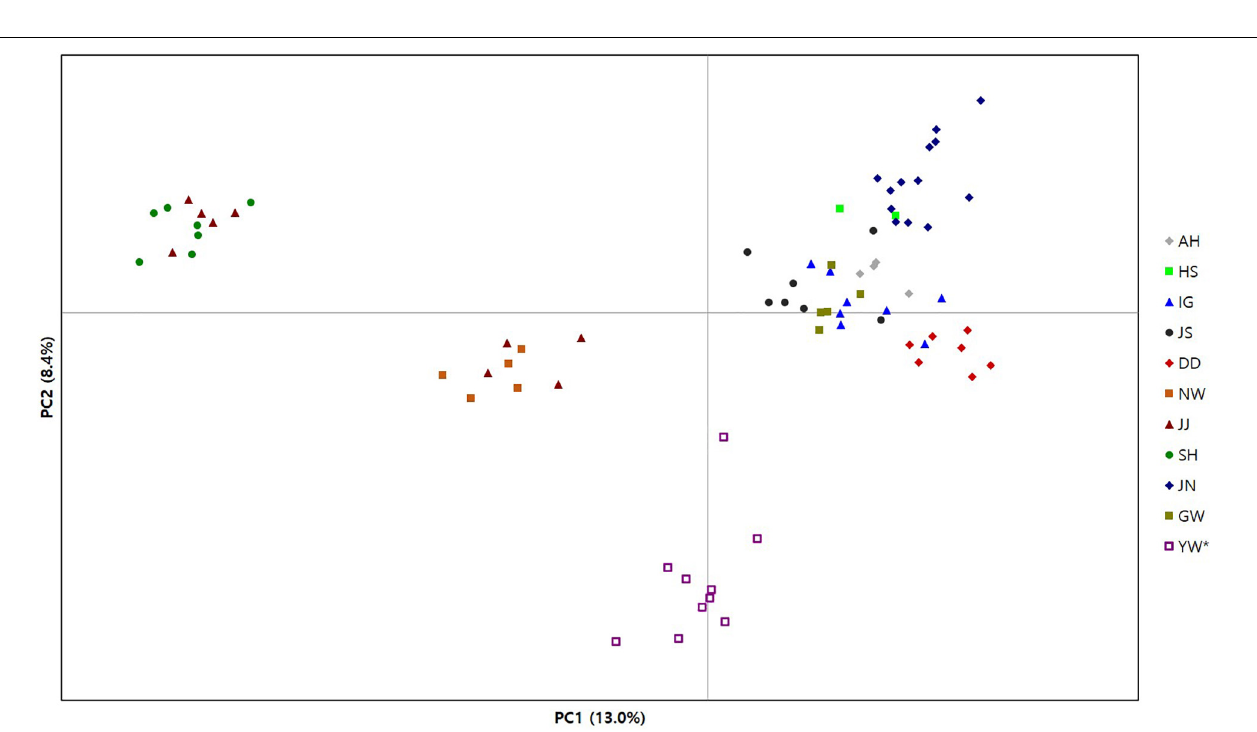
FIGURE 2 | Principal components analysis plot for 72 individual genotypes of Habenaria linearifolia and Habenaria cruciformis . The first two variance components from 2,734 SNPs were plotted. Table 1 shows abbreviations of population locations and sample sizes.